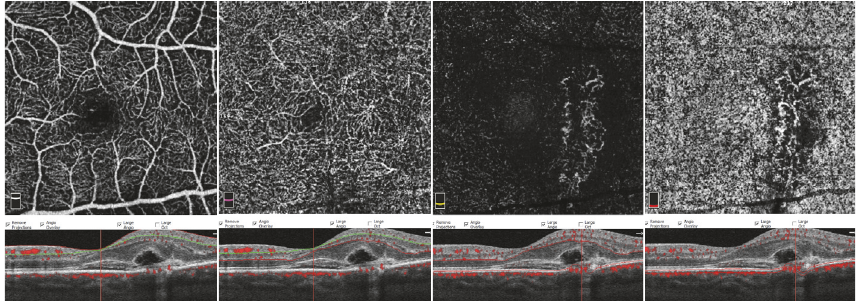
Figure 2: Optical coherence tomography angiography (OCTA): enface angiograms at 4-week visit. Angiograms of outer retina (A) and choriocapillaris (B) demonstrate the presence of a well circumscribed lesion with a clear hyperintense signal and characterized by numerous anastomotic vessels. Neovascular lesion extends along the primary RPE-Bruch membrane defect. OCT B-scan shows subretinal